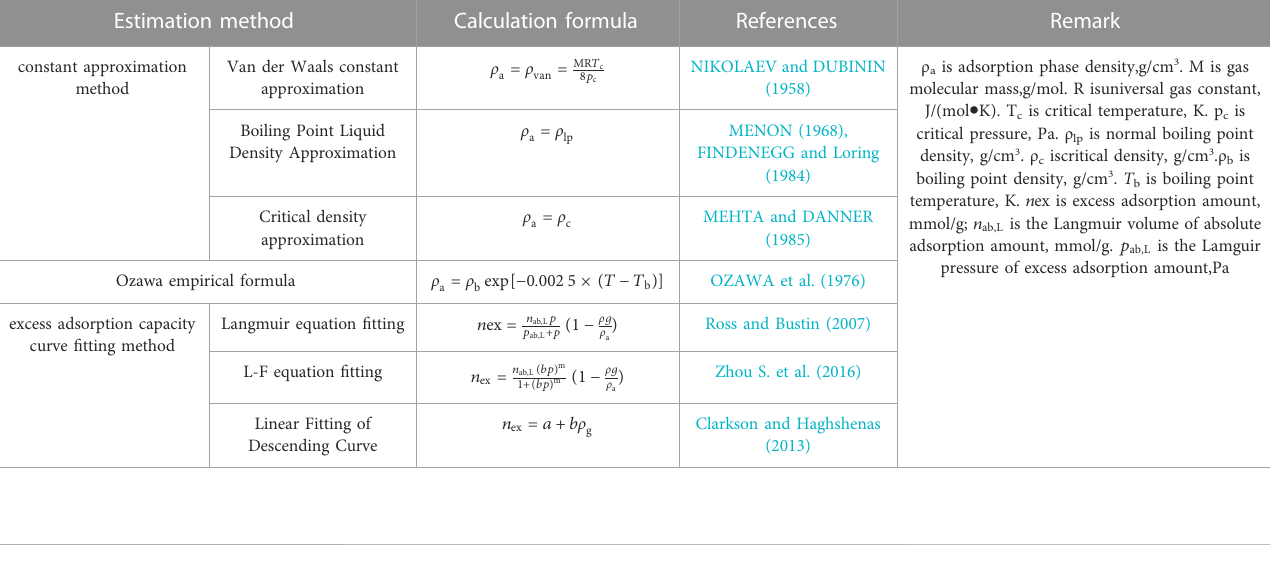
TABLE 2 The calculation method of adsorbed phase density.